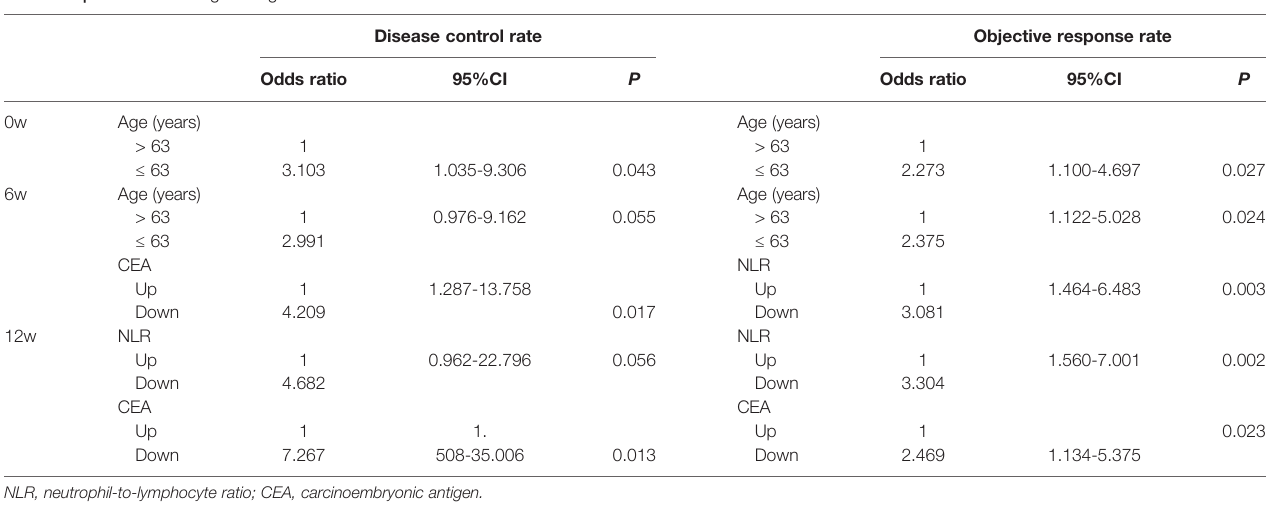
TABLE 3 | Multivariable Logistic regression models for DCR and ORR.